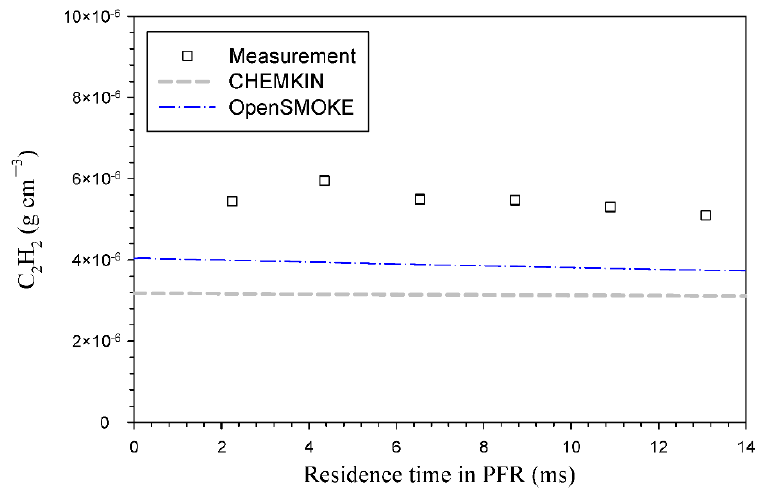
Figure 2. Comparison of C 2 H 2 concentrations predicted by CHEMKIN and OpenSMOKE++ with measured C 2 H 2 concentrations reported by Marr et al. [59].